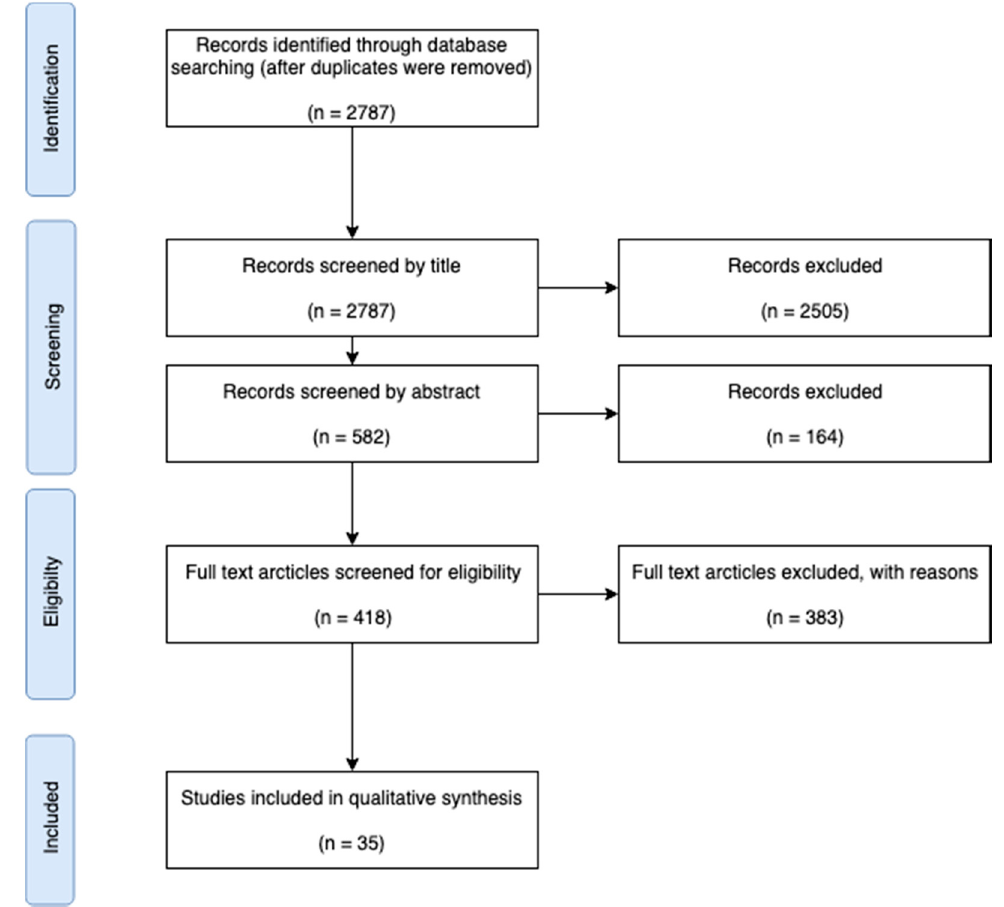
Figure A1. Flow chart diagram of the search and screening strategy.